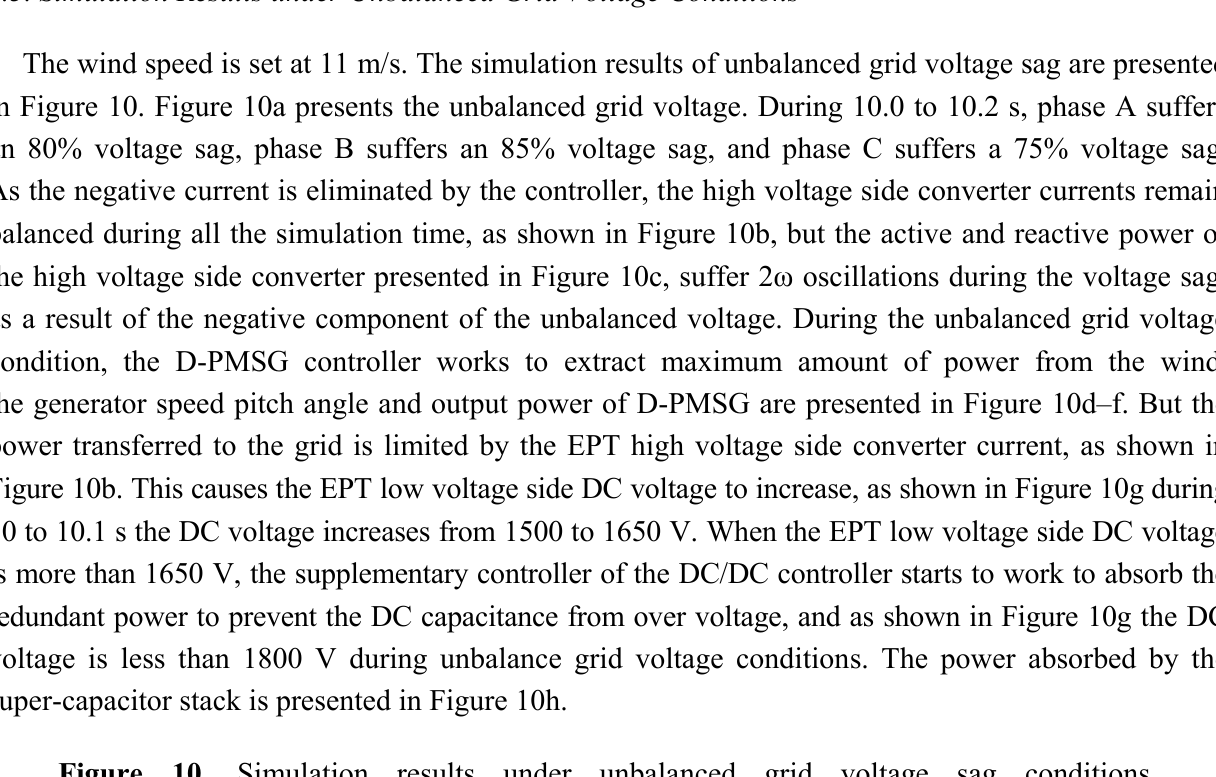
Figure 10. Simulation results under unbalanced grid voltage sag